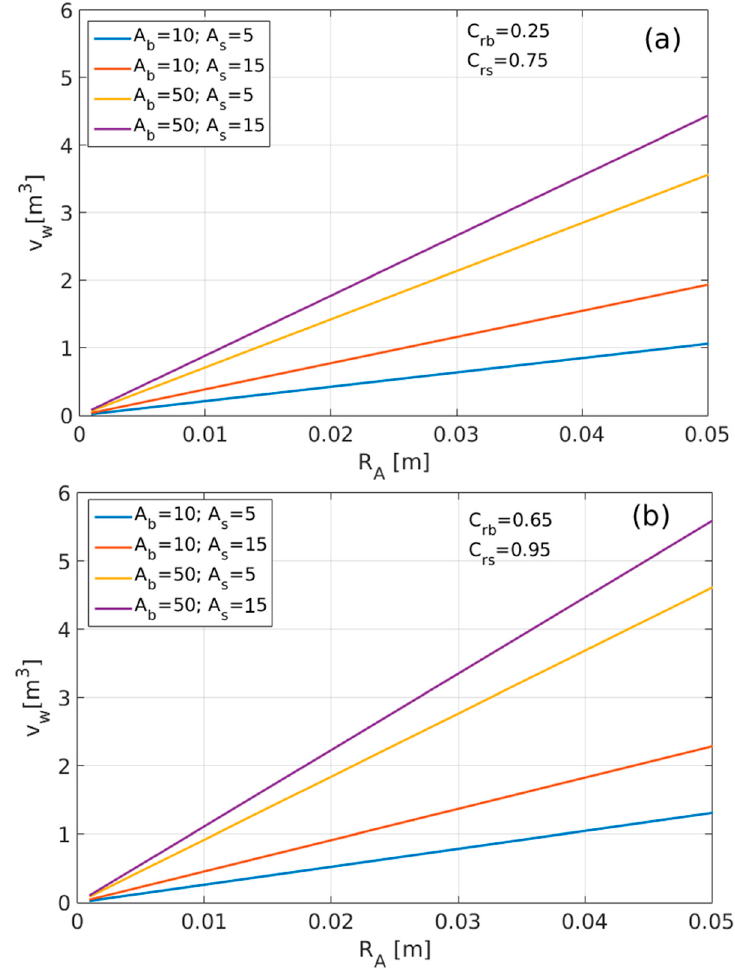
Figure 9. Modeling the volume of runoff water that drains through a spillway ( V w : m 3 ), according to area of drainage basin ( A b : m 2 ), area of uphill singletrack interval ( A s : m 2 ), runoff coefficient of drainage basin ( C rb ), runoff coefficient of uphill singletrack interval ( C rs ), and characteristic rainfall depths ( R A : m), for combinations of lowest ( a ) and highest ( b ) values of C rb and C rs .